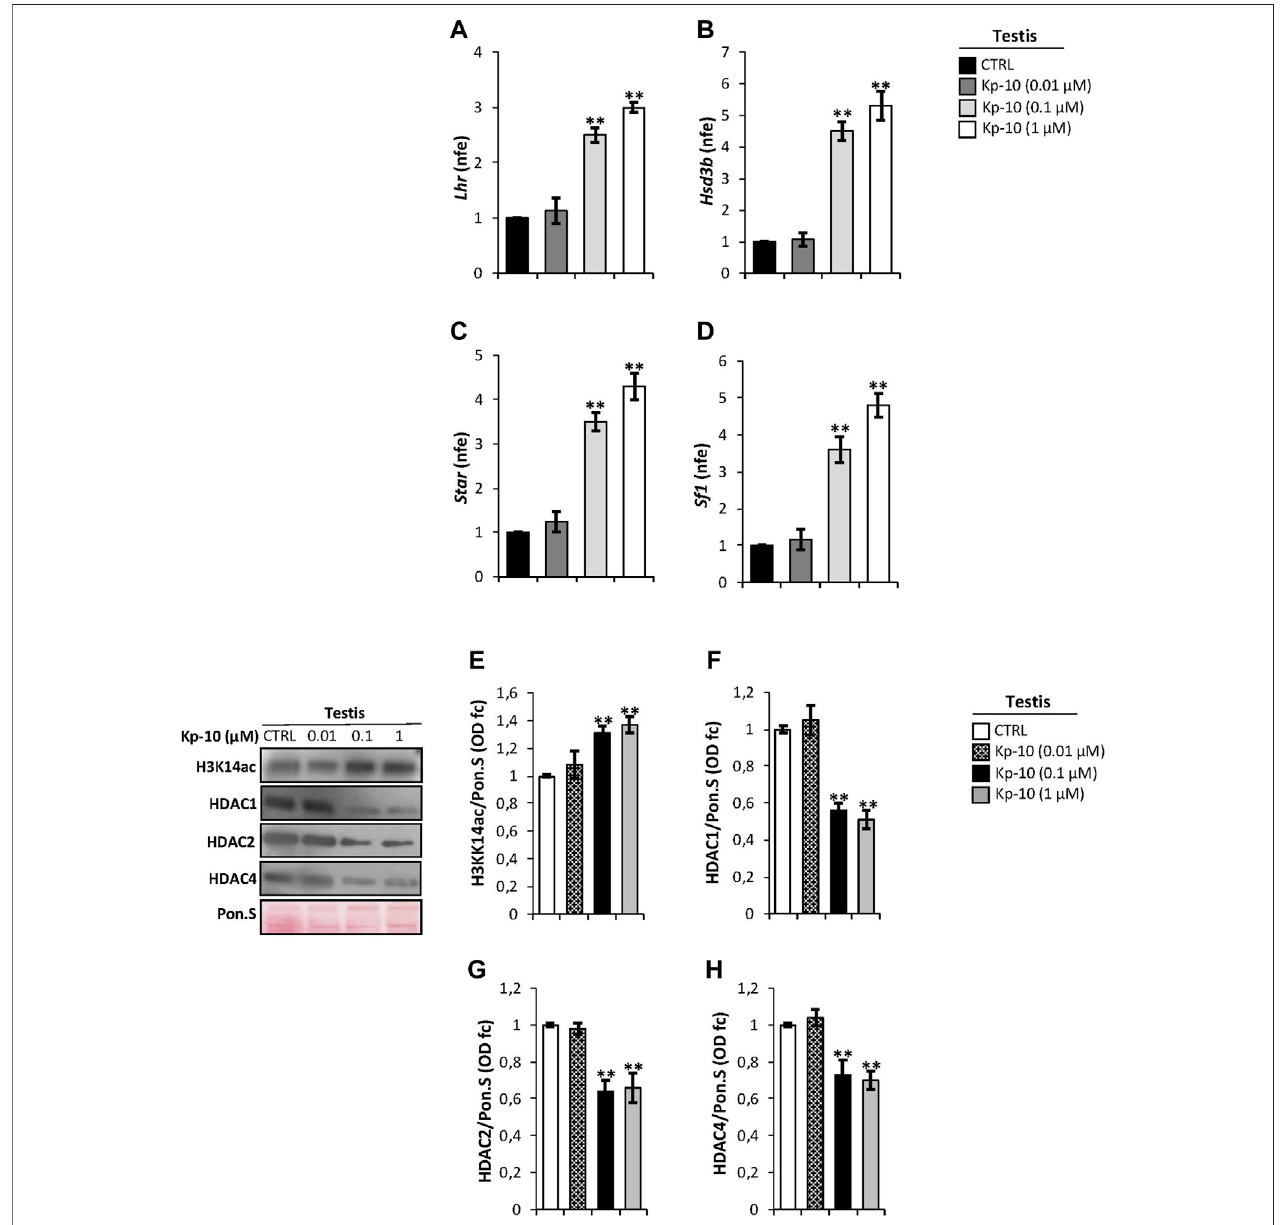
FIGURE 2 | (A – D) Differential expression analysis of Leydig cell genes in mice testes in vitro treated with different doses of Kp-10 (0.01 µM, 0.1 µM, and 1 µM), by qRT-PCR. (A) Lhr , (B) Hsd3b , (C) Star , and (D) Sf1 expression levels were normalized using Rp18S as a housekeeping gene and expressed as normalized fold expression (n.f.e.),relativelyto the CTRL group. All data are reported as mean value ± S.E.M; **p < 0.01. Western blot analysis of (E) H3K14ac, (F) HDAC1, (G) HDAC2, and (H) HDAC4protein levelsinmicetestes invitro treatedwithdifferentdosesofKp-10 (0.01 µM,0.1 µM,and1 µM).Signalswerequanti fi edbythedensitometry analysisandnormalizedtoPonceauRed(Pon.S).DataareexpressedinO.D.valuesasfoldchange(O.D.fc),relativelytotheCTRLgroup,andreportedasmean±SEM; ** p < 0.01.